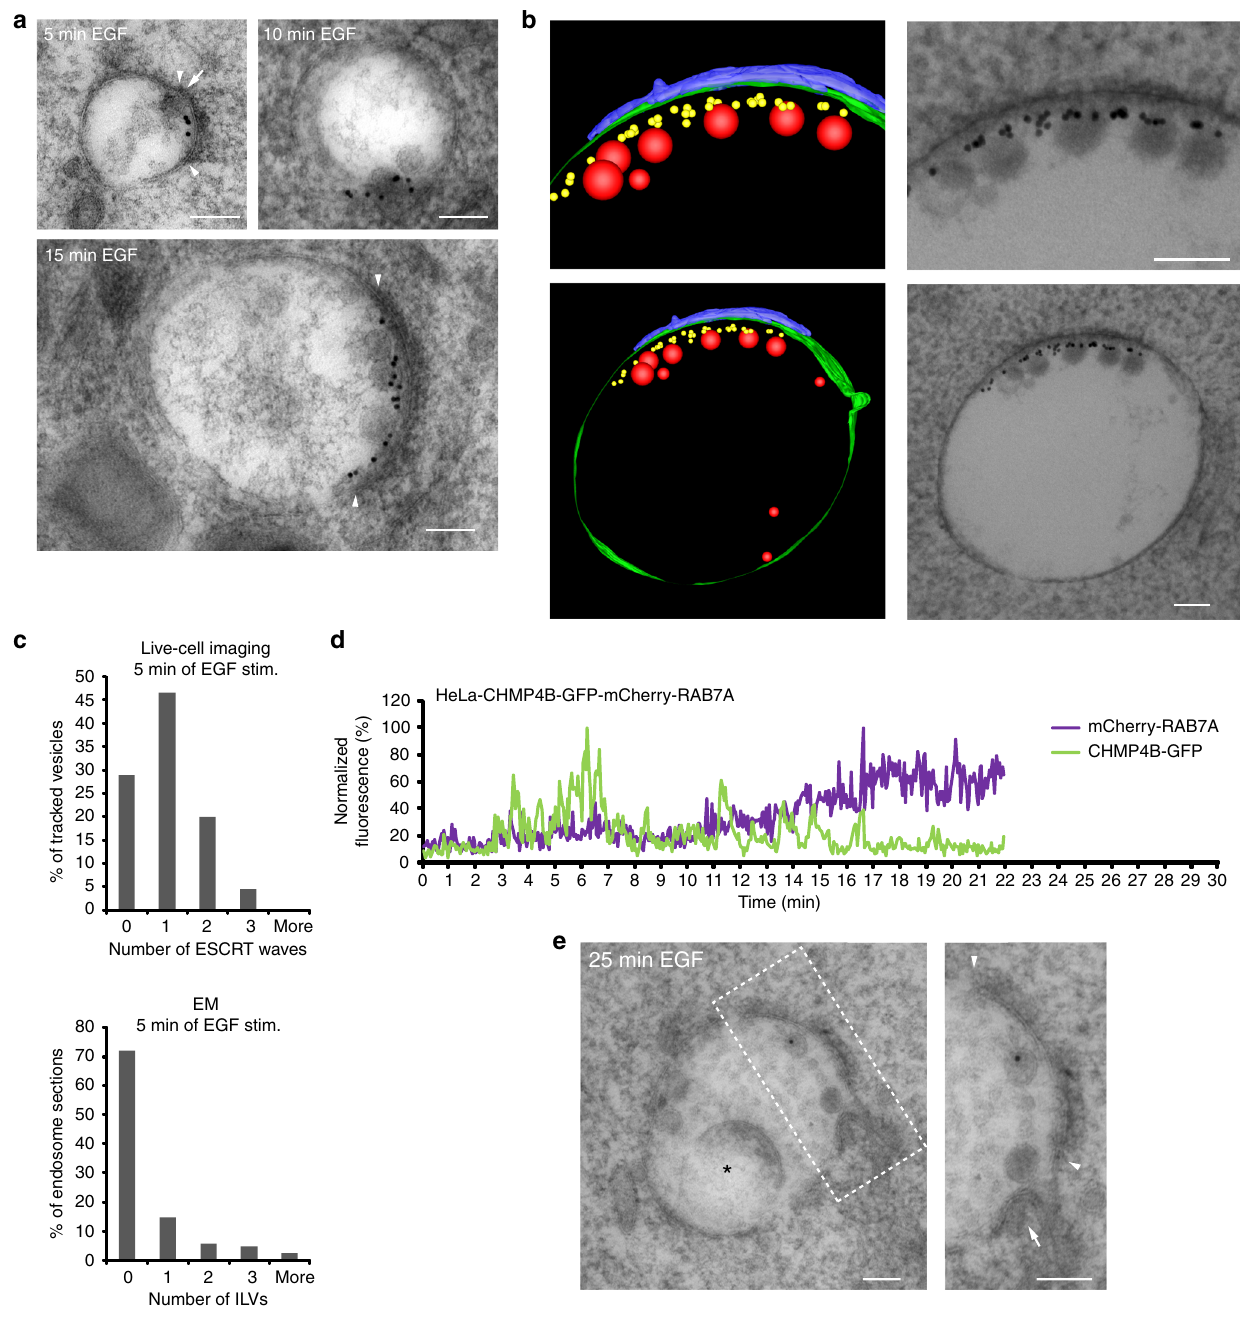
Fig. 3 One ESCRT recruitment wave results in the formation of a single ILV at a time. a Representative electron micrographs of endosomes from HeLa cells stimulated for 5, 10 or 15 min with EGF. The 10 nm gold particles mark newly internalized EGFR (see also Supplementary Fig. 4A). Note an ILV budding pro fi le in the 5 min sample (arrow) and an increasing number of ILVs formed over time, always in proximity to an endosomal EGFR/HRS/clathrin coat (boundaries marked by arrowheads). b Electron tomography of a 250nm thick section of a gold-labeled endosome with several ILVs. Note that completely abscised ILVs (red) are found in close proximity to the endosomal EGFR/HRS/clathrin coat (blue). c Quanti fi cation of the number of ESCRT waves after 5 min of EGF stimulation (upper histogram) and quanti fi cation of the number of ILVs observed per endosome section in electron microscopy after 5 min of EGF stimulation (lower histogram). ESCRT waves were counted from 64 endosomes from 21 independent live-cell imaging experiments. For the EM analysis at least 100 gold-labeled endosomes were analyzed from 3 independent samples. See also Supplementary Fig. 4 F, G, H. d Fluorescence intensity pro fi le of a tracked EGF-positive endosome over time from a CHMP4B-GFP and mCherry-RAB7 stably expressing HeLa cell. Note that CHMP4B-GFP fl ashing continues after the endosome has acquired RAB7. The track is one example from 15 tracks in total from 5 independent live-cell imaging experiments. e Electron micrograph of a gold-labeled endosome 25 min after EGF stimulation. Note that this endosome shows an ILV budding pro fi le (arrow) and at the same time a degradative structure (asterisk). Arrowheads indicate the boundaries of an EGFR/HRS/clathrin coat. All scale bars, 100